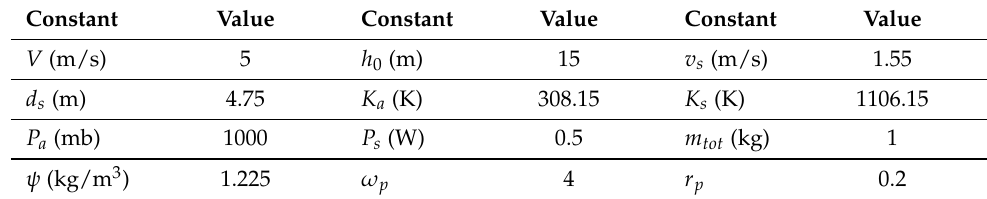
Table 2. The parameters used in the simulation.